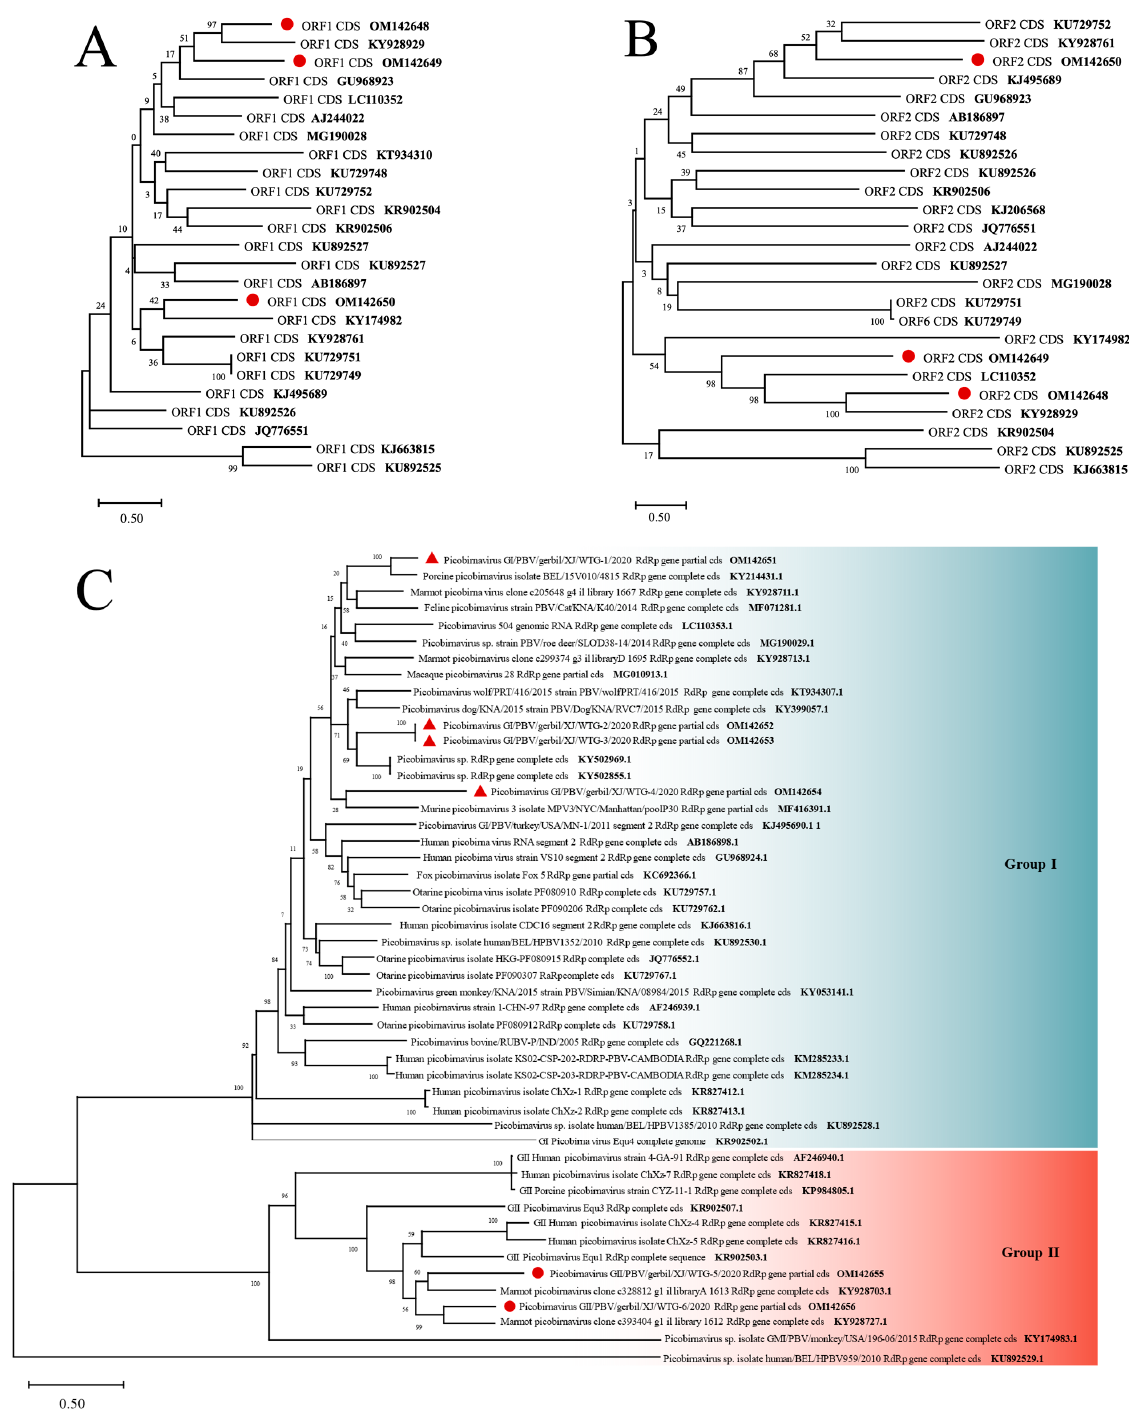
Figure 6. Maximum likelihood phylogenetic tree of Picobirnaviruses based on ( A ) ORF1; ( B ) ORF2; and ( C ) viral RNA-dependent RNA polymerase sequences of segment 2. GenBank accession numbers are followed by virus names. There were three closely related variants of PBVs (82.67%, 73.29%, 77.02% nucleotide identity in RdRp gene respectively) that were identified in the present study and are marked with a red triangle. The numbers beside the branches represent statistical confidence in clades based on 1000 bootstrap replicates, only bootstrap values ≥ 50% are shown. Scale bar (0.50) = nucleotide substitutions per